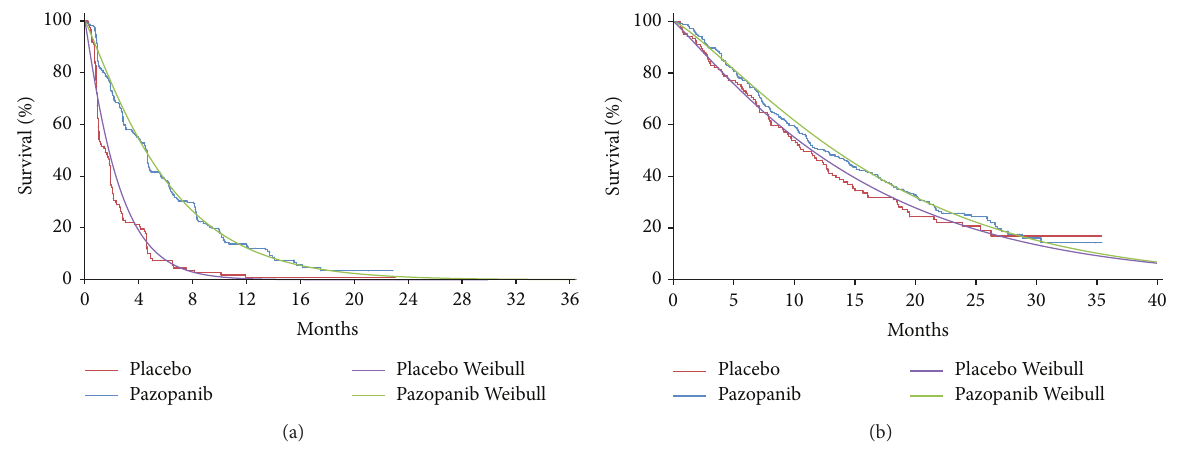
Figure 1: Weibull versus Kaplan-Meier survival distributions for (a) progression-free survival and (b) overall survival of pazopanib and placebo for patients in the PALETTE